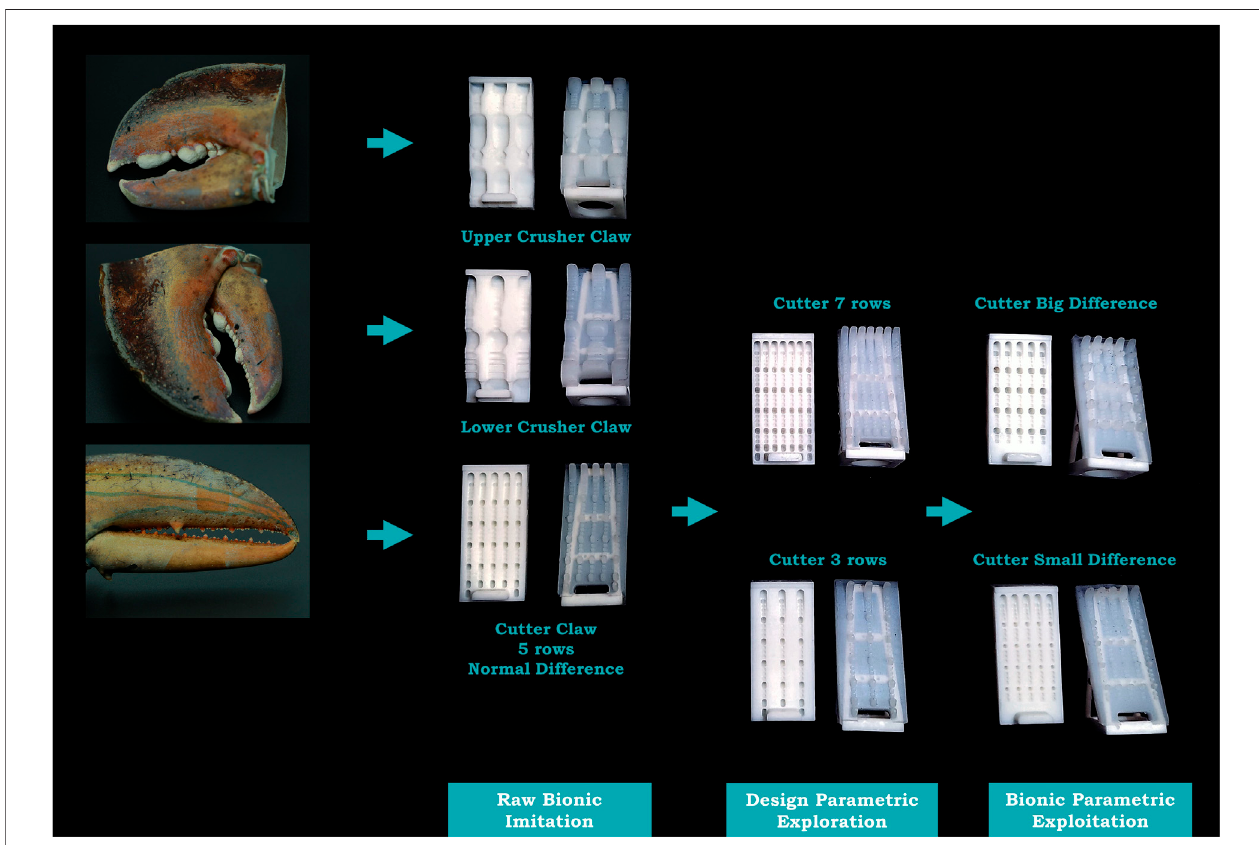
FIGURE 2 | Design iterations process used in this paper, including raw imitation, design parametric exploration, and bionic parametric exploitation, based on bio- inspiration from the rigid tooth pro fi les of the lobster, to the various soft fi nger surface designs used in this paper.